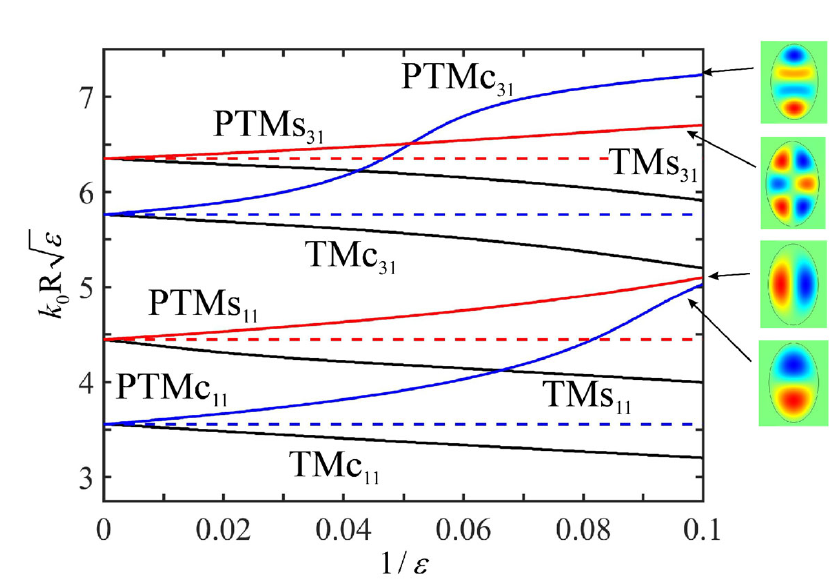
Figure 7. Eigenfrequencies k R  of even ((30), blue curves) and odd ((31), red curves) perfect 0 invisibility modes and quasi ‐ normal modes (black curves) versus 1/ ε for the ellipse with a/b = 1.6, m = 0, 2. The horizontal dashed lines correspond to the confined modes, that is, the solution of the   Ce , 0 q   and   Se , 0 q   . The insets show the H z distribution for the PTM equations 0 m 0 m modes.